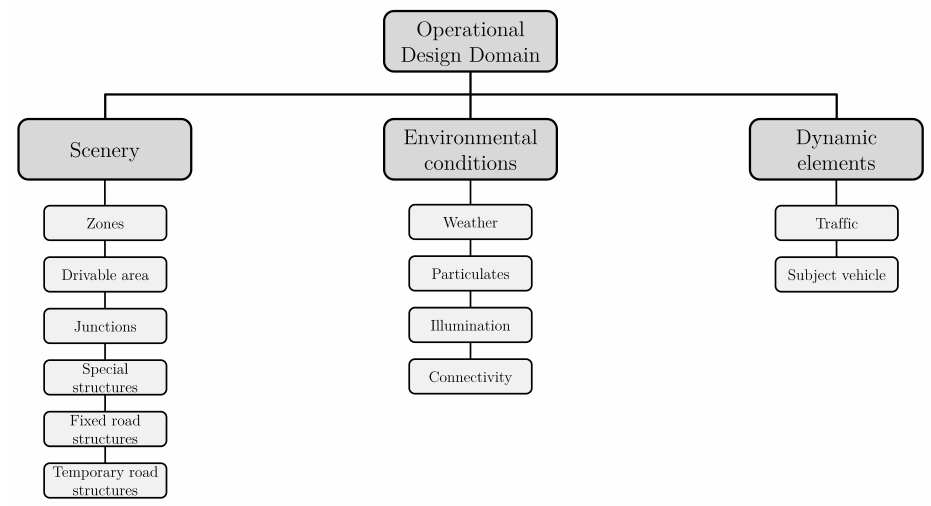
Figure 3. ODD categories and subcategories as defined in